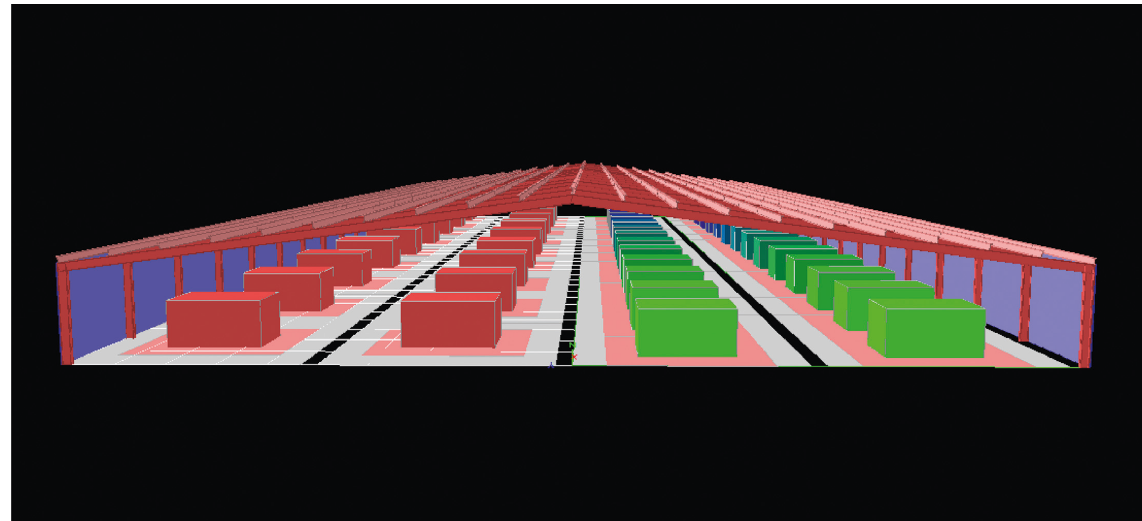
Figure 6: Process line after configuring the workspace and arranging the process